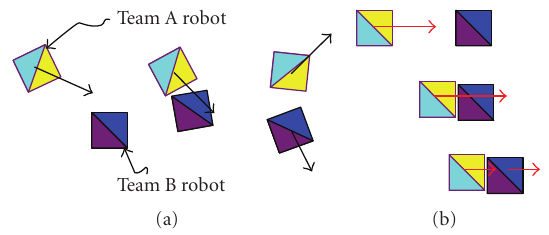
Figure 1: Two possible cases of collisions: “Hitting” and “Pushing.”